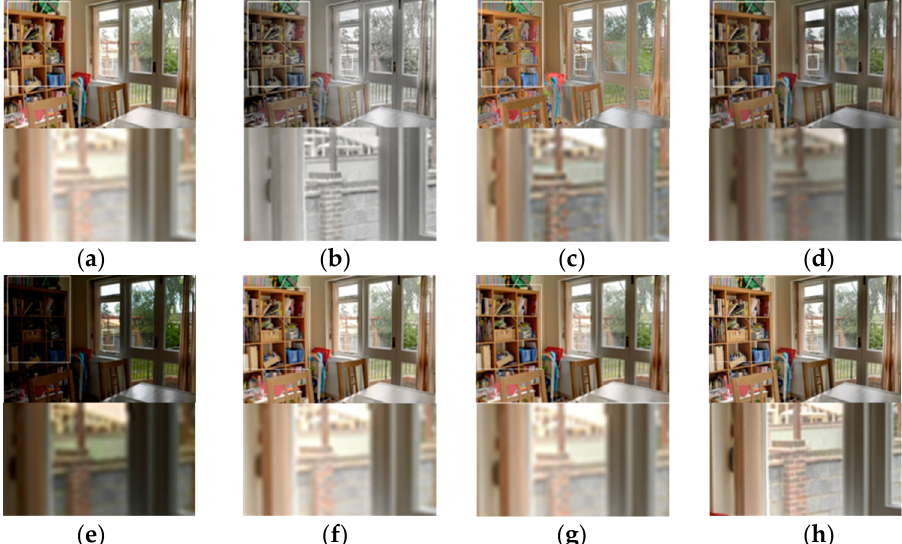
Figure 5. Results of different methods on the image sequence “Lighthouse”. ( a ) Mertens et al. [12]. ( b ) Gu et al. [16]. ( c ) Shen et al. [18]. ( d ) Bruce et al. [19]. ( e ) Photomatix [36]. ( f ) Hayat et al. [21]. ( g ) Huang et al. [22]. ( h ) Proposed method.